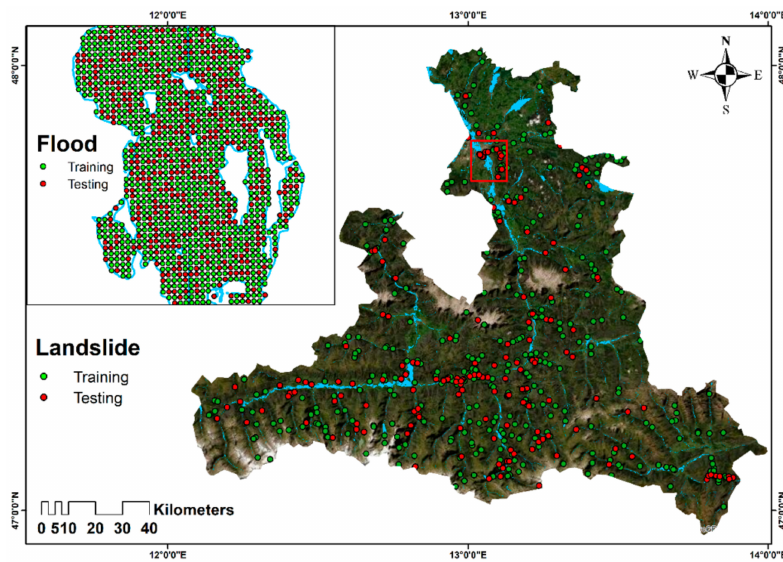
Figure 2. The State of Salzburg showing the flood and landslide inventory divided into training and testing